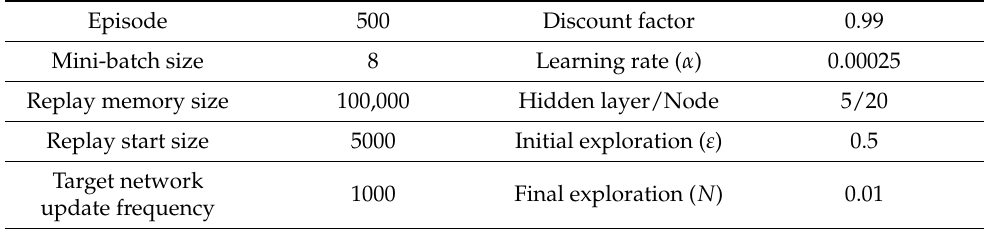
Table 2. DQN training hyperparameters.